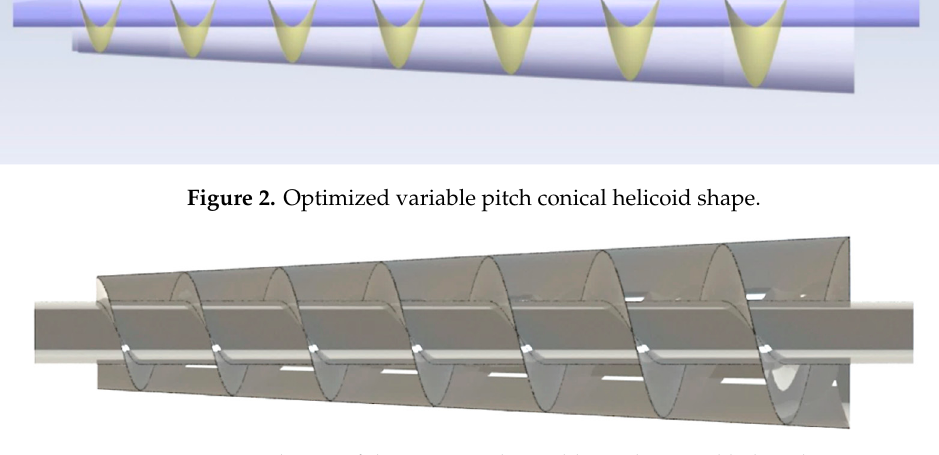
Figure 3. Rendering of the optimized variable pitch conical helicoid.